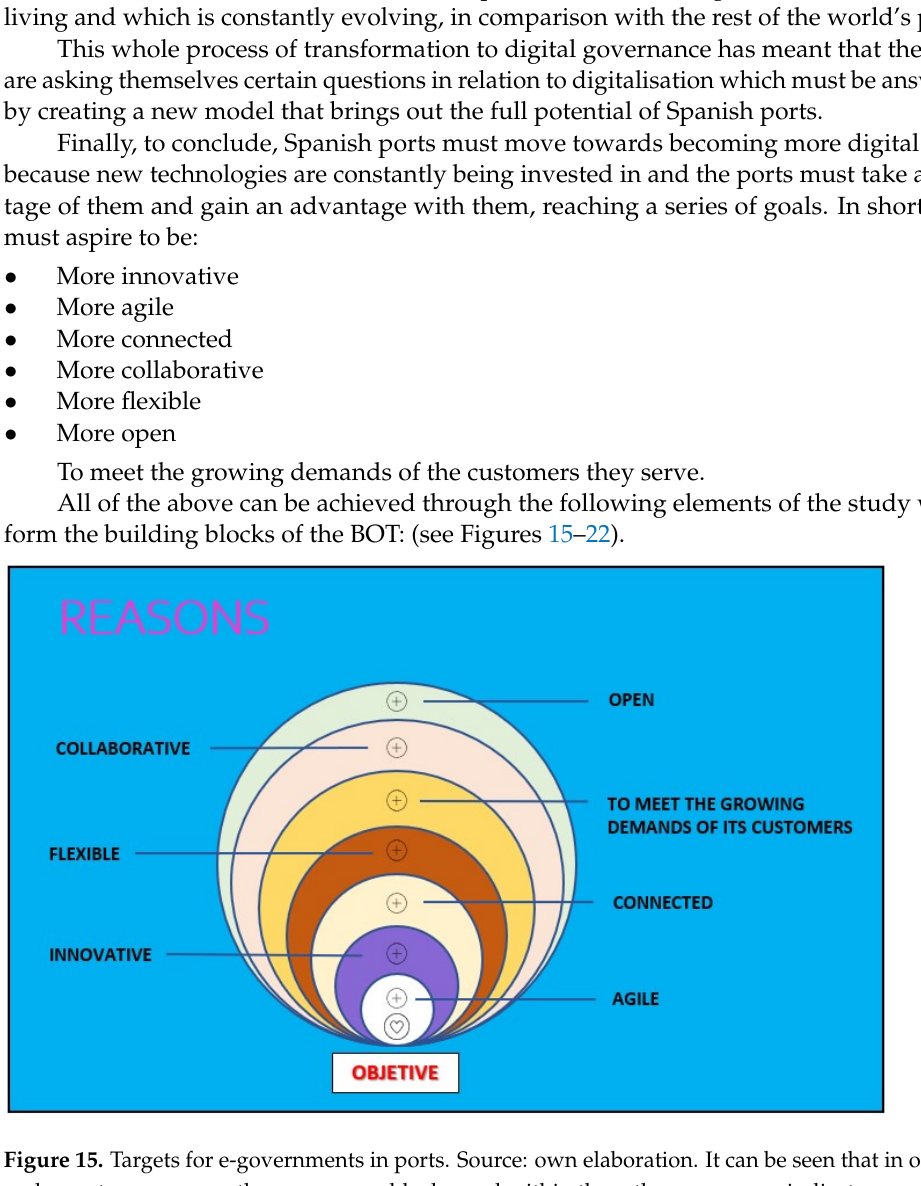
Figure 15. Targets for e-governments in ports. Source: own elaboration. It can be seen that in order to make ports more open, there are many blocks, and within them there are many indicators